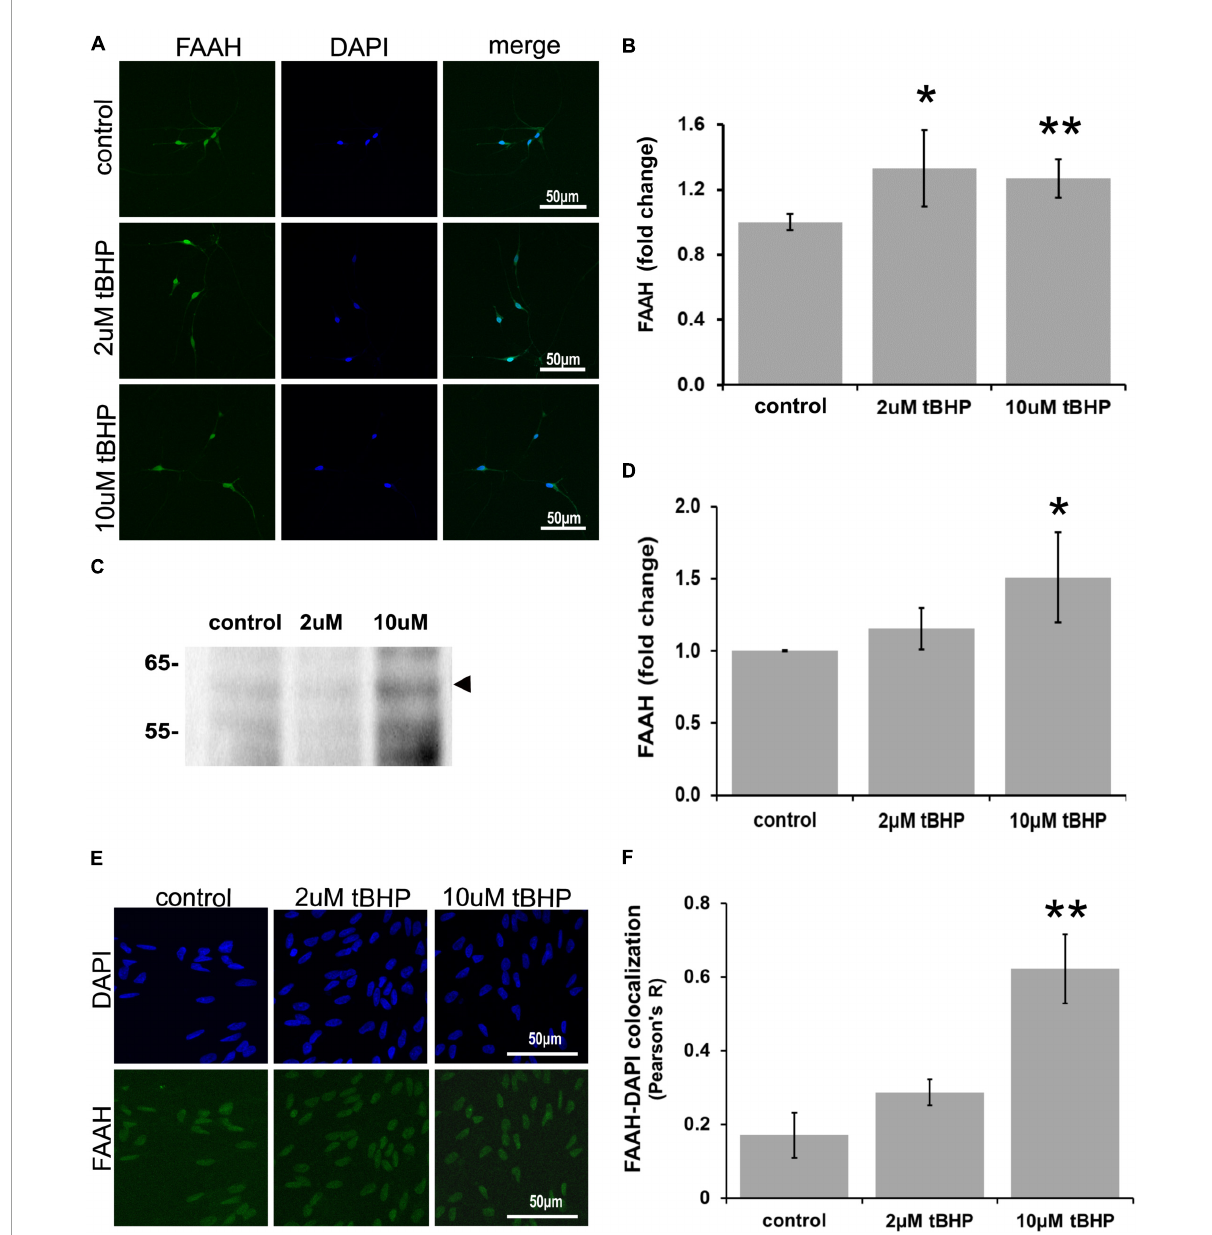
FIGURE4 Expression of fatty acid amide hydrolase (FAAH) in ReN cells under conditions of oxidative stress. Exposure of ReN cells to sublethal concentrations of tert-butylhydroperoxide (tBHP) led to an increase in FAAH expression (A,B) . Green fluorescence is FAAH and blue fluorescence is DAPI. (C,D) Western blot analysis reveals that the expression of a 63 kDa band corresponding to FAAH is unaffected by exposure to 2 µ M tBHP but upregulated 1.5-fold by 10 µ M tBHP. The expected molecular weight of FAAH is 63 kDa. (E,F) Colocalization analysis between FAAH immunoreactivity with DAPI fluorescence (DNA) reveals low colocalization at resting untreated conditions ( R = 0.18), but 2 µ M tBHP exposure led to a 68% increase in Pearson’s R (from 0.17 to 0.28). Higher tBHP concentrations (10 µ M) led to a large (3.6-fold) increase in FAAH-DAPI colocalization (from R of 0.17 to 0.62), suggesting significant FAAH localization in the nucleus near DNA. * p ≤ 0.05, ** p ≤ 0.01.